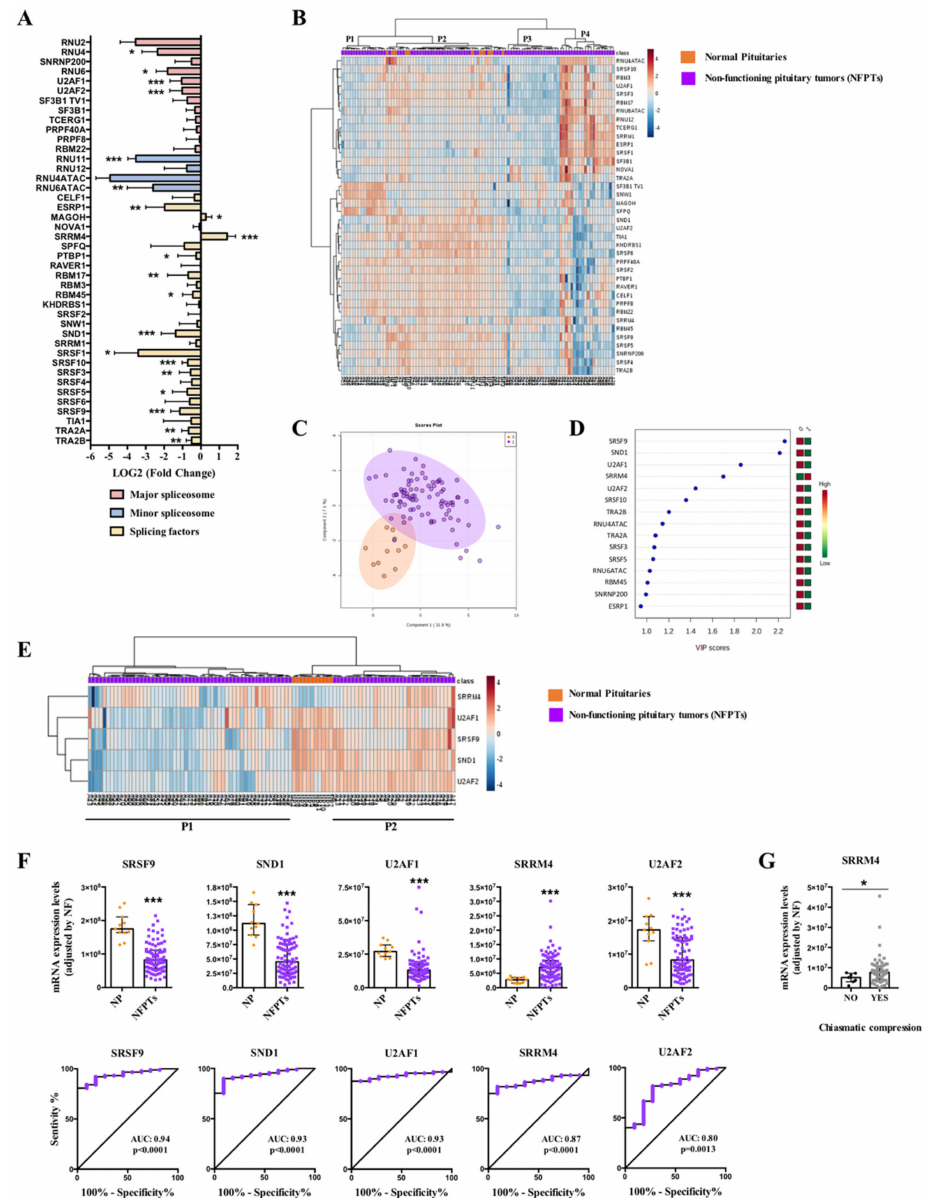
Figure 1. Non-functioning pituitary tumors (NFPTs). ( A ) Individual Fold-Change of each splicing- regulatory element expression levels in NFPTs compared to normal pituitary glands (NPs). ( B ) Heatmap of the mRNA expression levels of all splicing-regulatory elements measured in the qPCR array in NFPTs ( n = 88; green color) compared to NPs ( n = 11; red color). ( C ) Principal Components Analysis (PCA) of the mRNA expression levels of the splicing-regulatory elements analyzed in the same set of samples. ( D ) Variable Importance in Projection (VIP) Scores top-feature of Partial Least Squares Discriminant Analysis (PLS-DA). ( E ) Heatmap of the splicing-regulatory elements with higher VIP score in the same set of samples. ( F ) mRNA expression levels of splicing-regulatory elements with higher VIP score in NFPTs compared to NPs and Receiver Operating Characteristic (ROC) curves analyses showing the accuracy of the selected splicing-regulatory elements to discriminate between NFPTs and NPs. ( G ) Correlations between SRRM4 and chiasmatic compression in NFPTs. Data represent median ± interquartile range of absolute expression levels (copy number) of each transcript adjusted by a normalization factor. Asterisks (* p < 0.05, ** p < 0.01, *** p < 0.001) indicate statistically significant di ff erences between